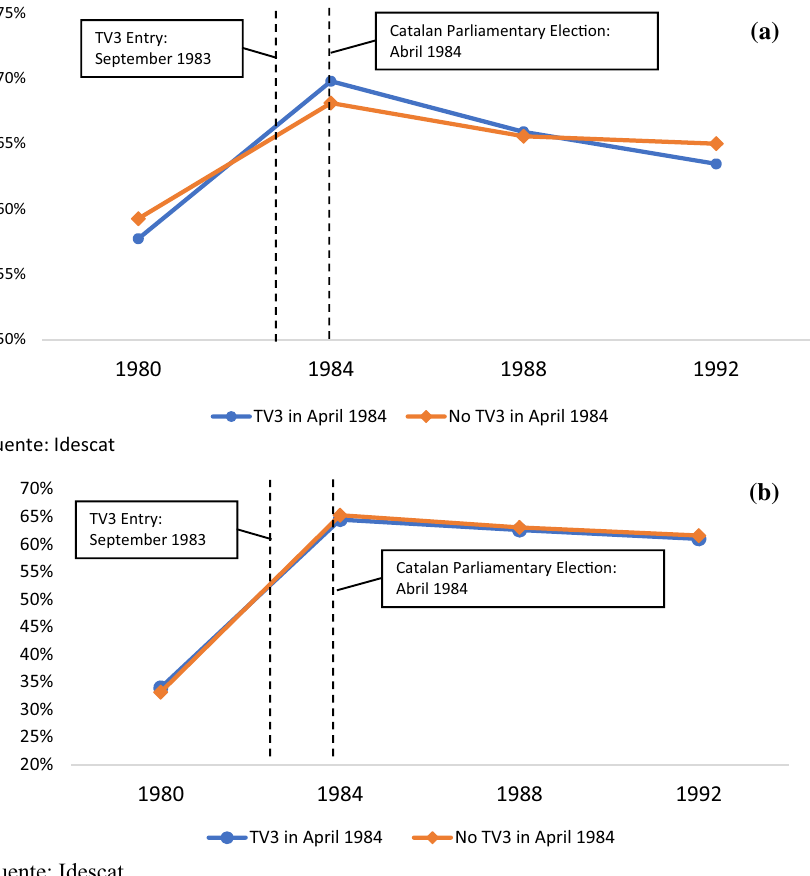
Fig. 2 Evolution of voter turnout and CiU vote share. a Voter Turnout in Catalan parliamentary elections, b CiU Vote Share in Catalan parliamentary elections, c Voter Turnout in National Congress (Congreso de los Diputados) Elections and d CiU Vote Share in National Congress (Congreso de los Diputados)